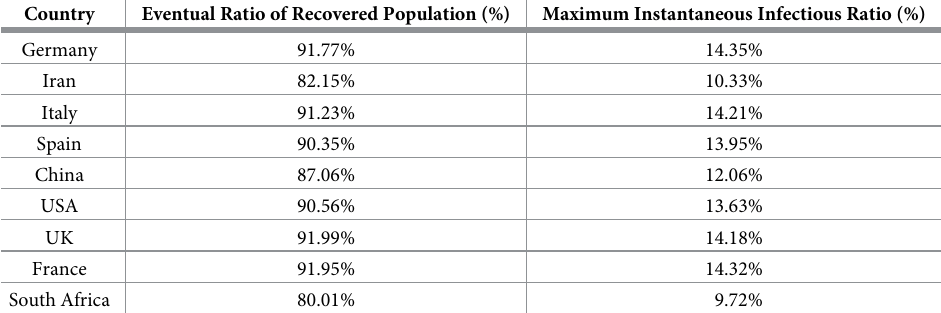
Table 1. Maximum Instantaneous Infectious ratio and eventual Recovered ratio for the spread of SARS-CoV-2 in different countries assuming the population is uncontained. The Recovered compartment includes those individuals who have been Infectious and then were recovered or